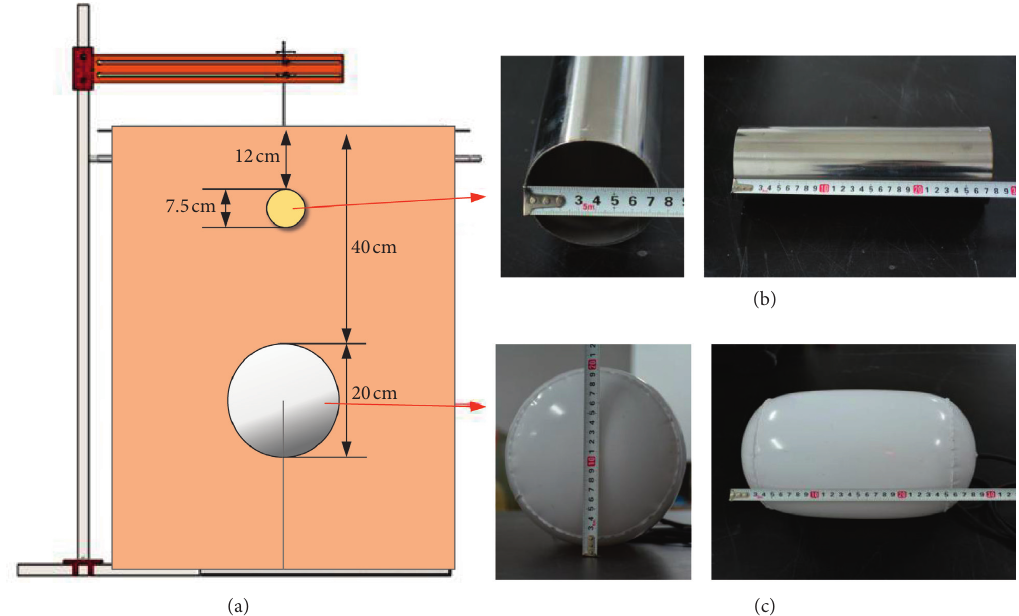
Figure 3: Model design. (a) Model design parameters. (b) Simulated cavity. (c) Simulated